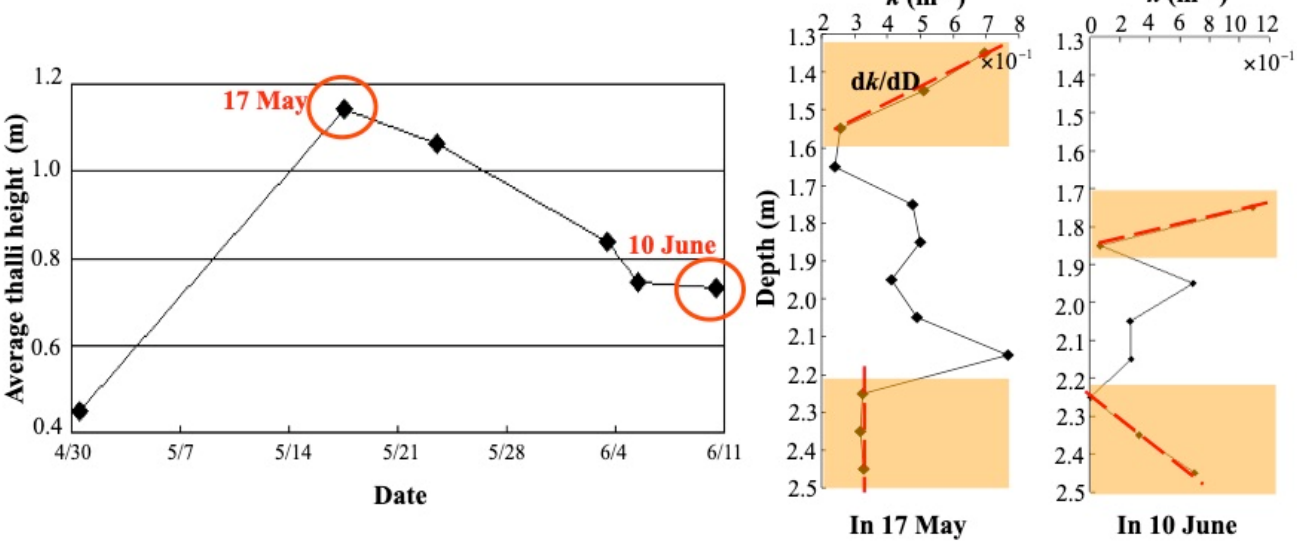
Figure 3. Variations in the average thalli height with the growing date from April 30 to June 11 of Sargassum horneri and comparsions of light attenuation rate k (unit: m − 1 ) and dk/dD (unit: m − 2 ) vary- ing with depth (unit: m) on May 17 and June 10 in 2010 in Houtouwan.